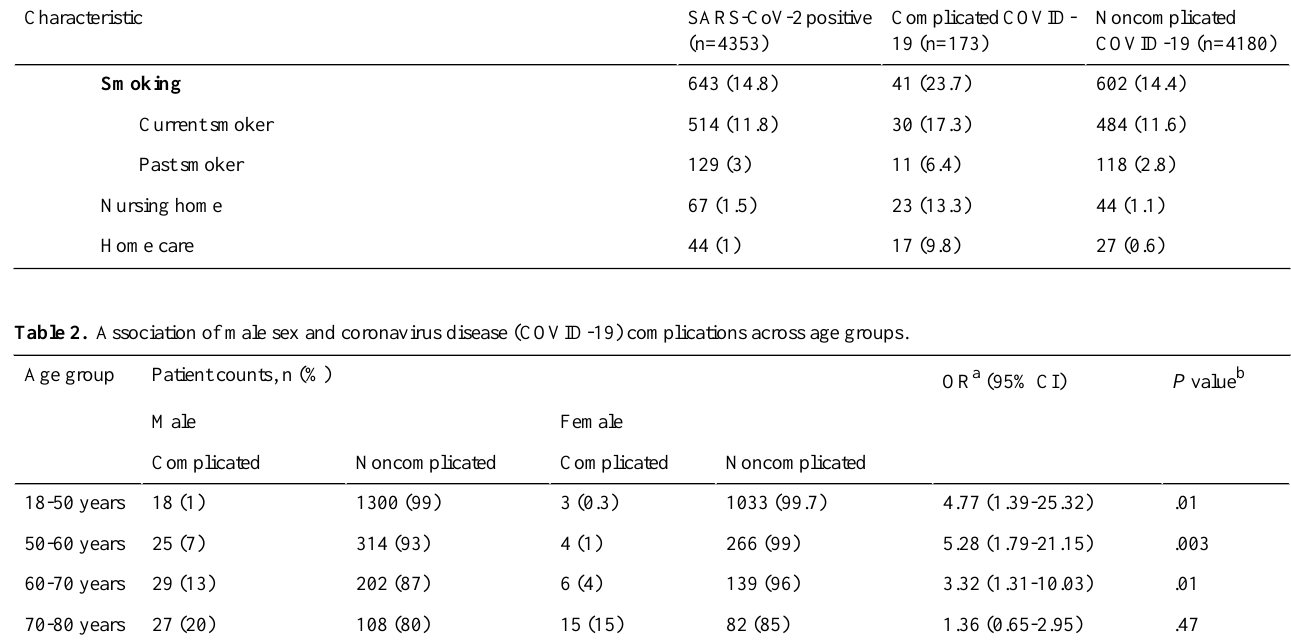
.151.93 (0.89-4.26)57 (72)22 (28)32 (57)24 (43) ≥ 80